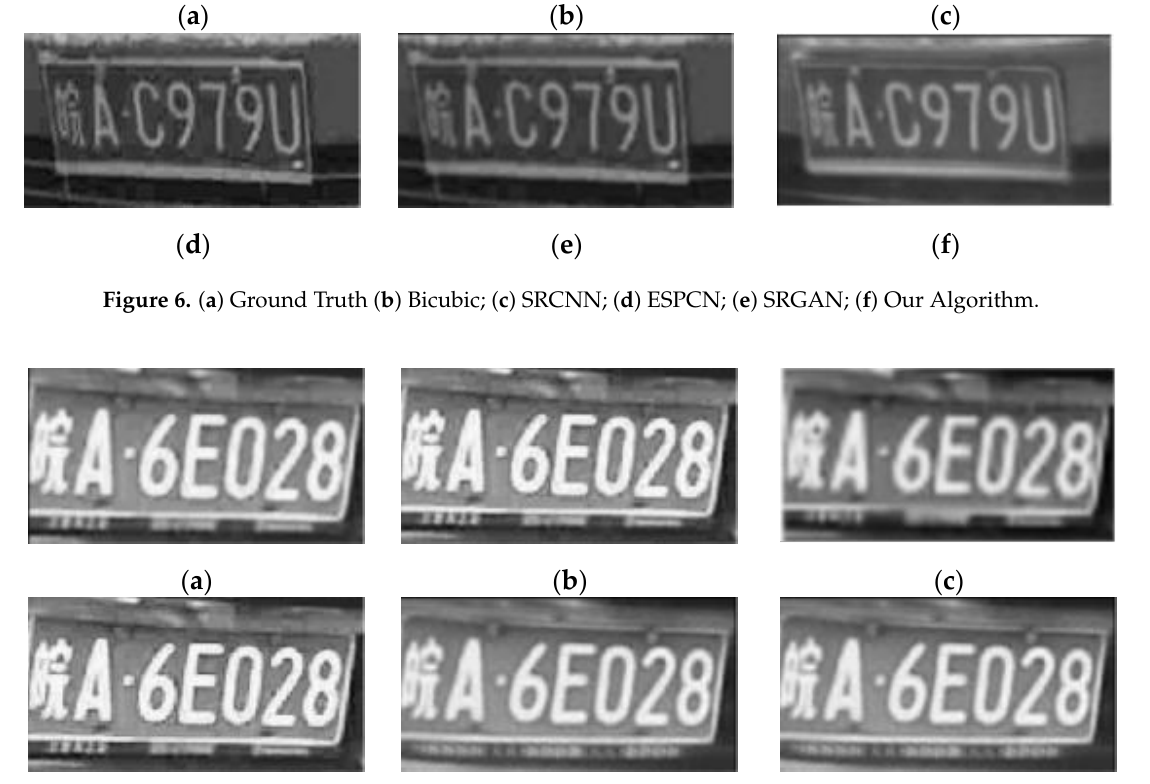
Figure 7. ( a ) Ground Truth ( b ) Bicubic; ( c ) SRCNN; ( d ) ESPCN; ( e ) SRGAN; ( f ) Our Algorithm.